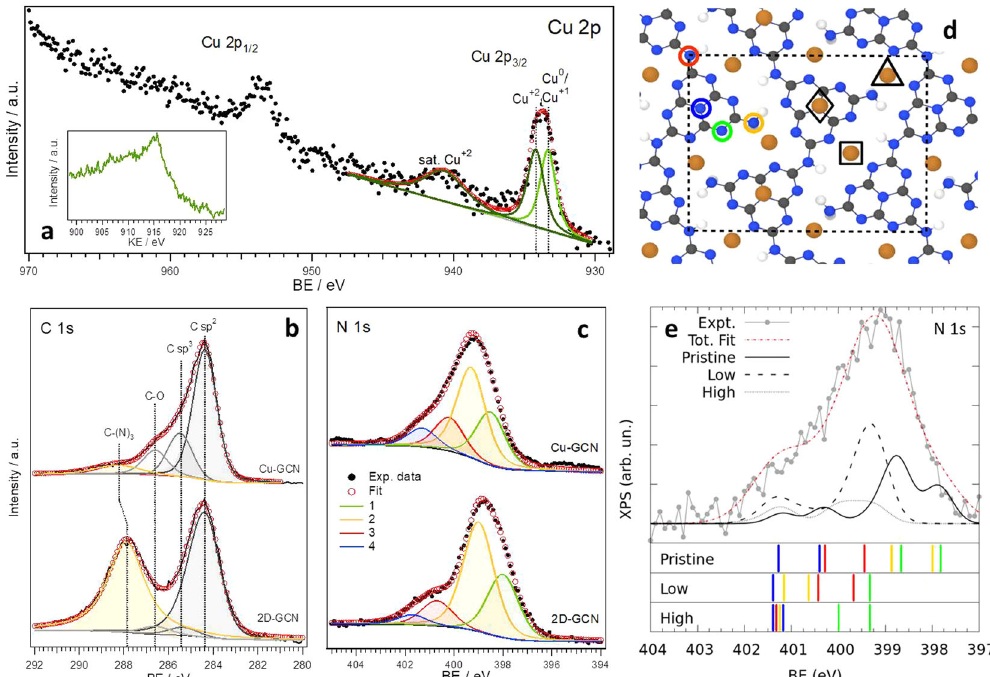
Fig. 3 Determination of the GCN adsorption sites and the coordination of the Cu atoms. a − c Cu 2p, C 1s, and N 1s regions of experimental XPS and their corresponding deconvolution. The inset in ( a ) shows the LMM Auger peak of Cu. For the attribution of the N 1s components in ( c ), see Table S2 and Fig. S3e. d Top view of the structure of one model included in the ‘ high ’ coverage regime of Cu-GCN: C, N, H, and Cu are represented by grey, blue, white, and orange spheres, respectively. The green, orange, red and blue circles indicate the inequivalent N atoms, namely pyridinic, primary amino, secondary amino, and graphitic, respectively. Additionally, the triangle, square, and rhombus indicate the ‘ Amino I ’ , ‘ Amino II ’ and ‘ Top ’ adsorption sites for Cu. e Simulated N 1s XPS spectrum of the mixture of coverage regimes (dashed red line) compared with the experimental one for Cu-GCN(20) (dotted grey line); contributing spectra from different regimes are also shown; below, lines for different N atoms at each regime (for pristine, lines of alternated and linear models are resolved whereas for low and high coverage regimes there is no resolution for different